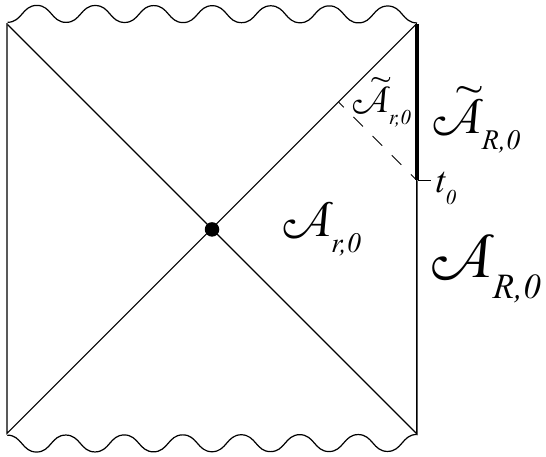
Figure 3 . The boundary Type III subalgebra e A R, 0 ⊆ A R, 0 describing noncentral single-trace operators at times t > t 0 is holographically dual to the bulk QFT subalgebra e A r, 0 ⊆ A r, 0 describing the causal wedge of the